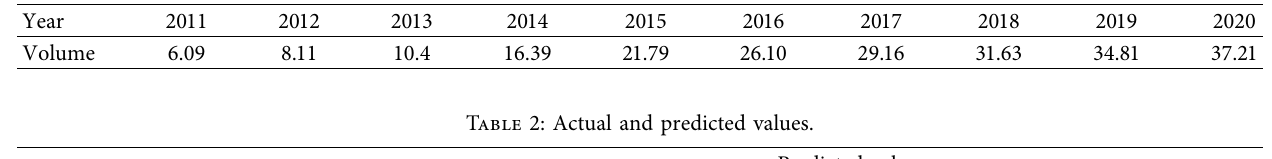
Table 1: China’s e-commerce transaction volume (unit: trillion Chinese Yuan).